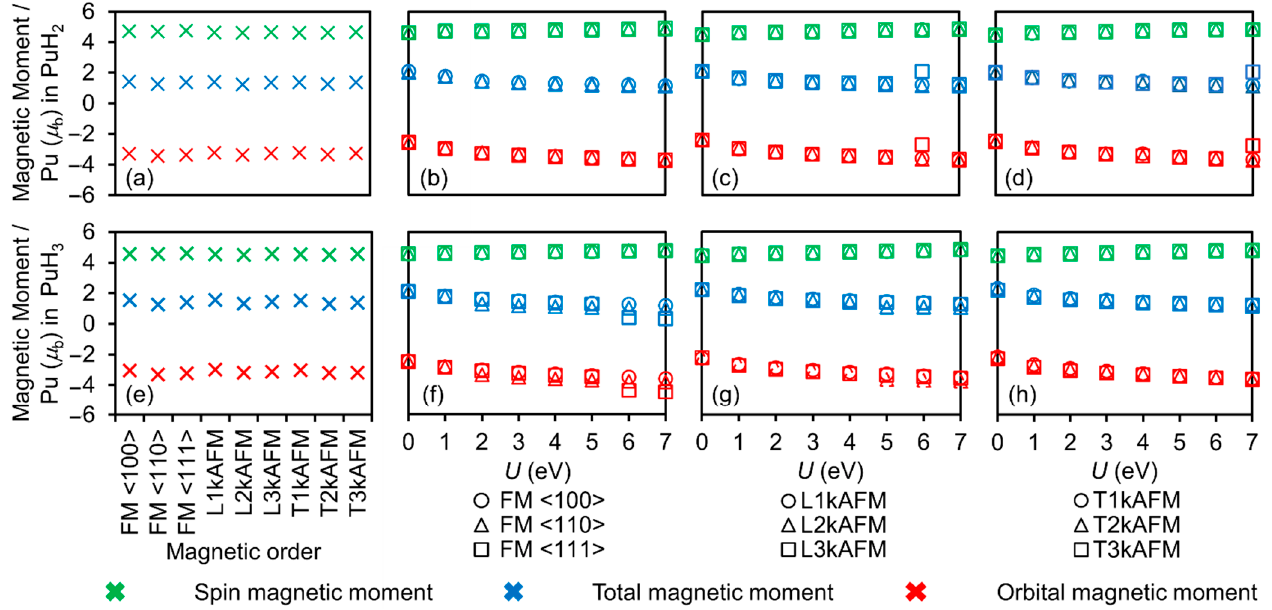
Figure 6. Spin (green), orbital (red) and total (blue) magnetic moments calculated using HSE06sol+SOC for ( a ) cubic PuH 2 and for ( e ) PuH 3 and using PBEsol+ U +SOC for cubic PuH 2 and for PuH 3 ( b , f ) FM <100>, <110> and <111>, ( c , g ) longitudinal AFM 1k, 2k and 3k, and ( d , h ) transverse AFM 1k, 2k and